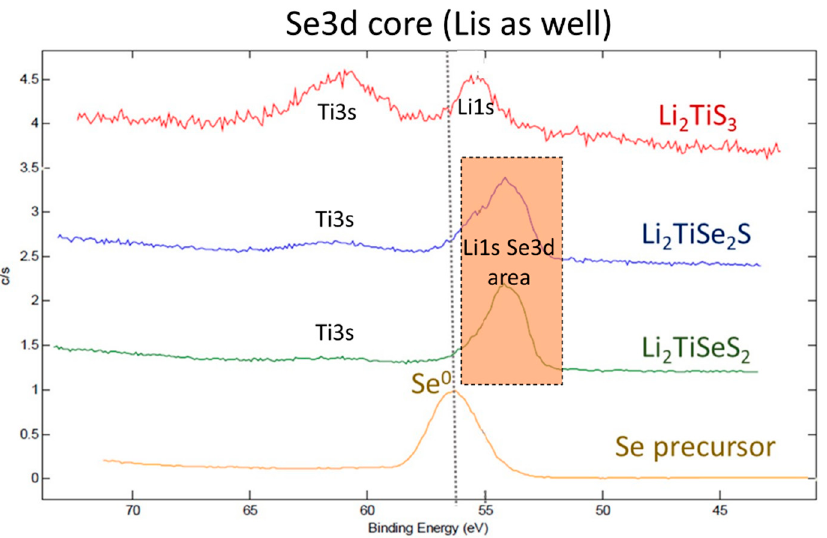
Figure 10. XPS spectra of powders: Li 2 TiS 3 , Li 2 TiSeS 2 , and Li 2 TiSe 2 S and selenium precursor at Se3d core.